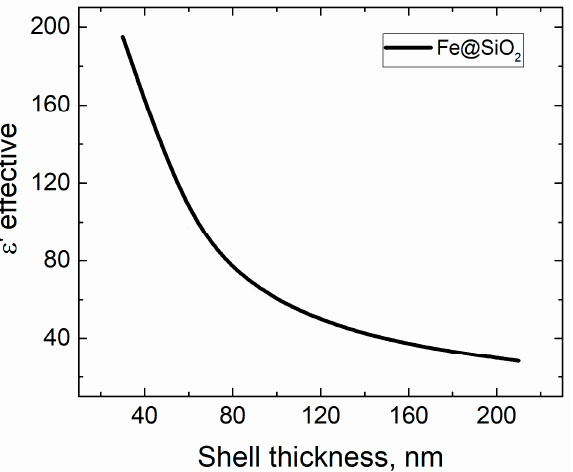
Figure 10. Calculated effective permittivity vs. SiO 2 shell thickness of the Fe@SiO 2 “composite” Fe@SiO 2 –paraffin wax real composite.